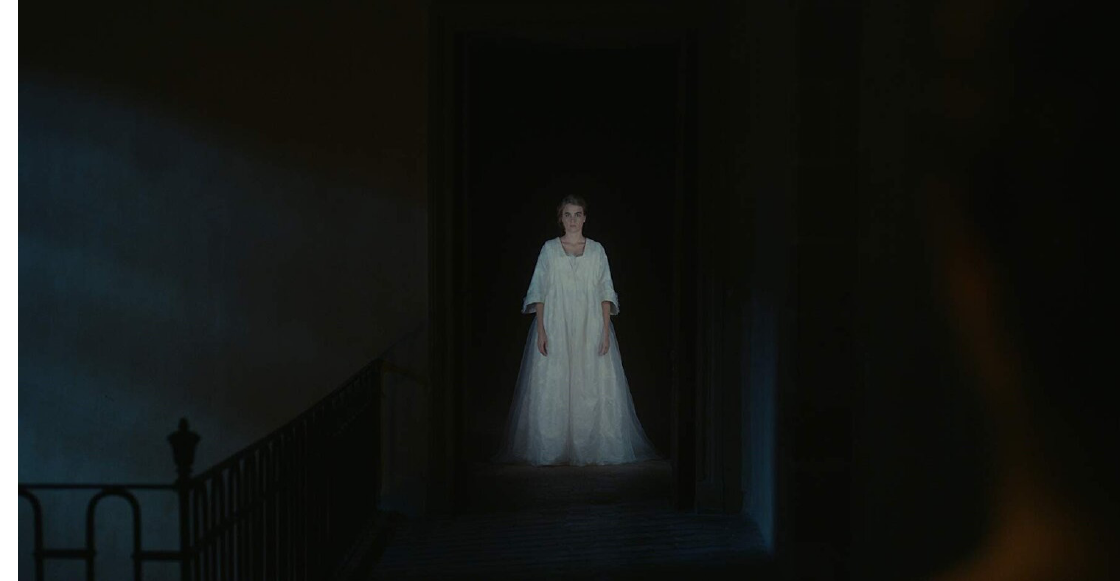
Figure 4. The ghost of Héloïse in her wedding clothes in Portrait of a Lady on Fire, dir. Céline Sciamma (2019). Screenshot © Lilies Films.